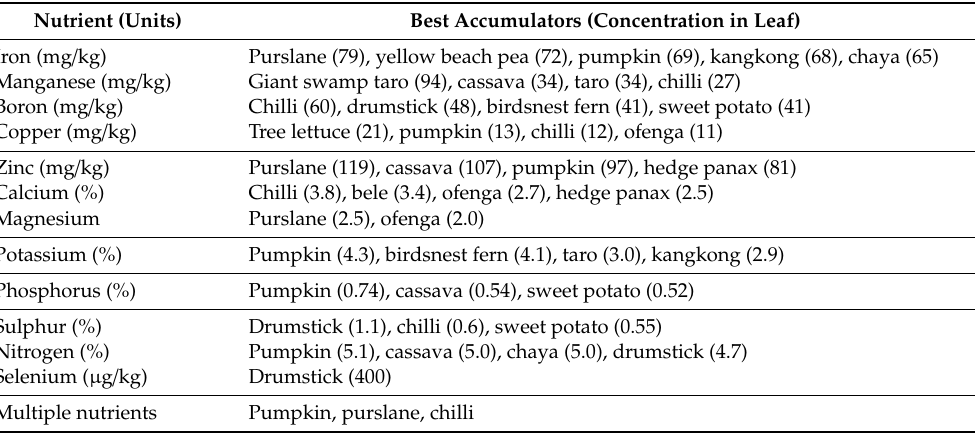
Table 4. Selected mineral nutrients and the leafy vegetable species found (using opportunistic GxE analysis) in this study to be the most e ff ective accumulators of these minerals in leaves. Samples were collected from various locations in Kiribati and Tuvalu. The values in brackets are representative concentrations of the relevant mineral for each species in this